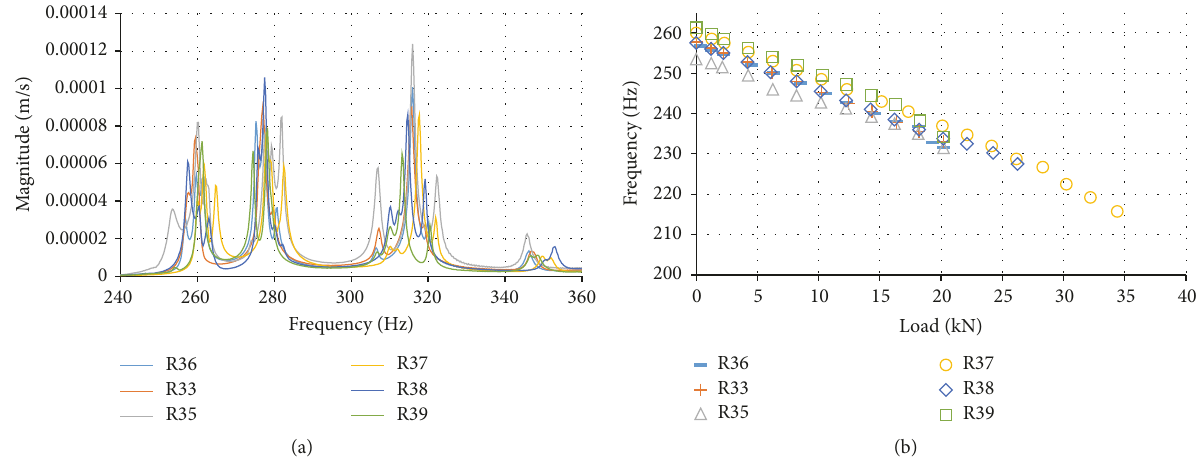
Figure 14: Natural frequency response of unloaded cylinders with cutouts (a) and reduction of the first natural frequency with increasing axial load (b).